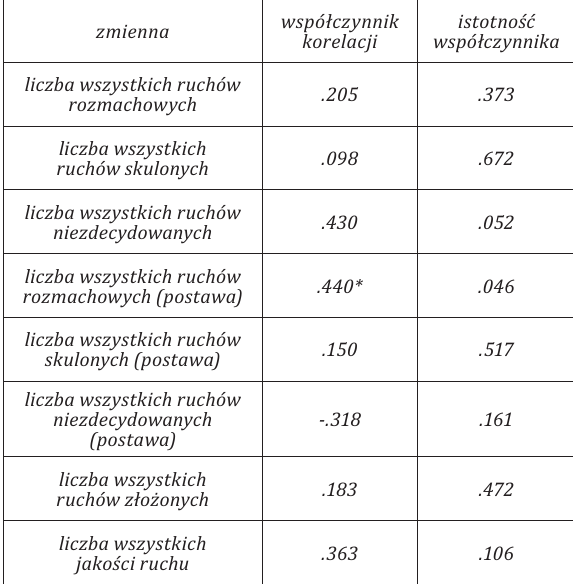
Tabela 7. Wartości rho Spearmana między zmienną „światłocienie” a zmiennymi dotyczącymi jakości ruchów w grupie osób zdrowych (N=21)